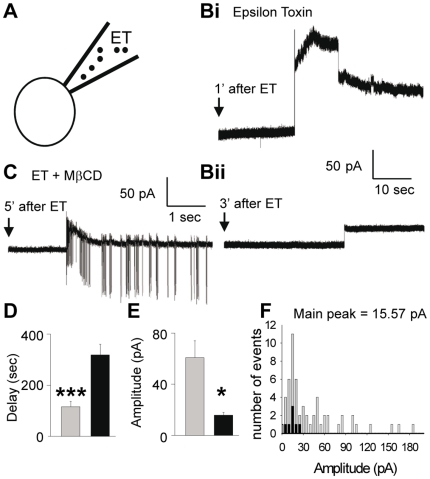
Abrupt current changes induced by ET in membrane patches.A, Schematic representation of the recording configuration (Cell attached). ET (10−7 M) was applied inside the patch-pipette. B–C, typical membrane current changes recorded after sealing the patch-pipette onto a granule cell membrane (membrane potential maintained at −45 mV using the Voltage Clamp mode), without pre-treatment (Bi, Bii) or after pre-treatment (C) for 30 min with 1 mM of methyl-β-cyclodextrin (MβCD). The corresponding average delays (D) before current changes were detected, and average amplitude of the detected current changes (E), and distribution amplitude (F) of the observed current changes. Grey and black bars denote experiments performed using ET alone (mean from 34 recordings) or after pre-treatment with MβCD (mean from 16 recordings) respectively.